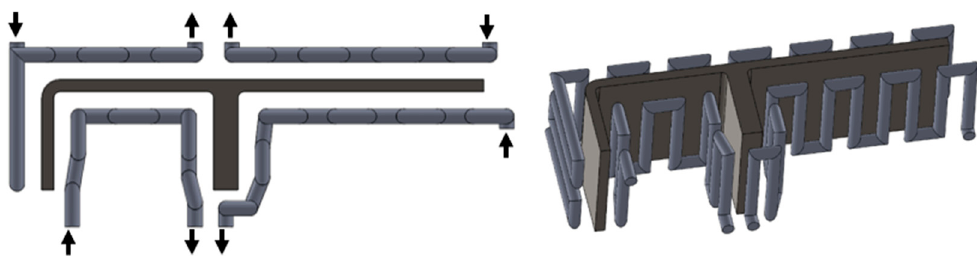
Figure 4. The four independent equidistant cooling circuits are shown in a plan view on the left and together with the test specimen in isometric view on the right.